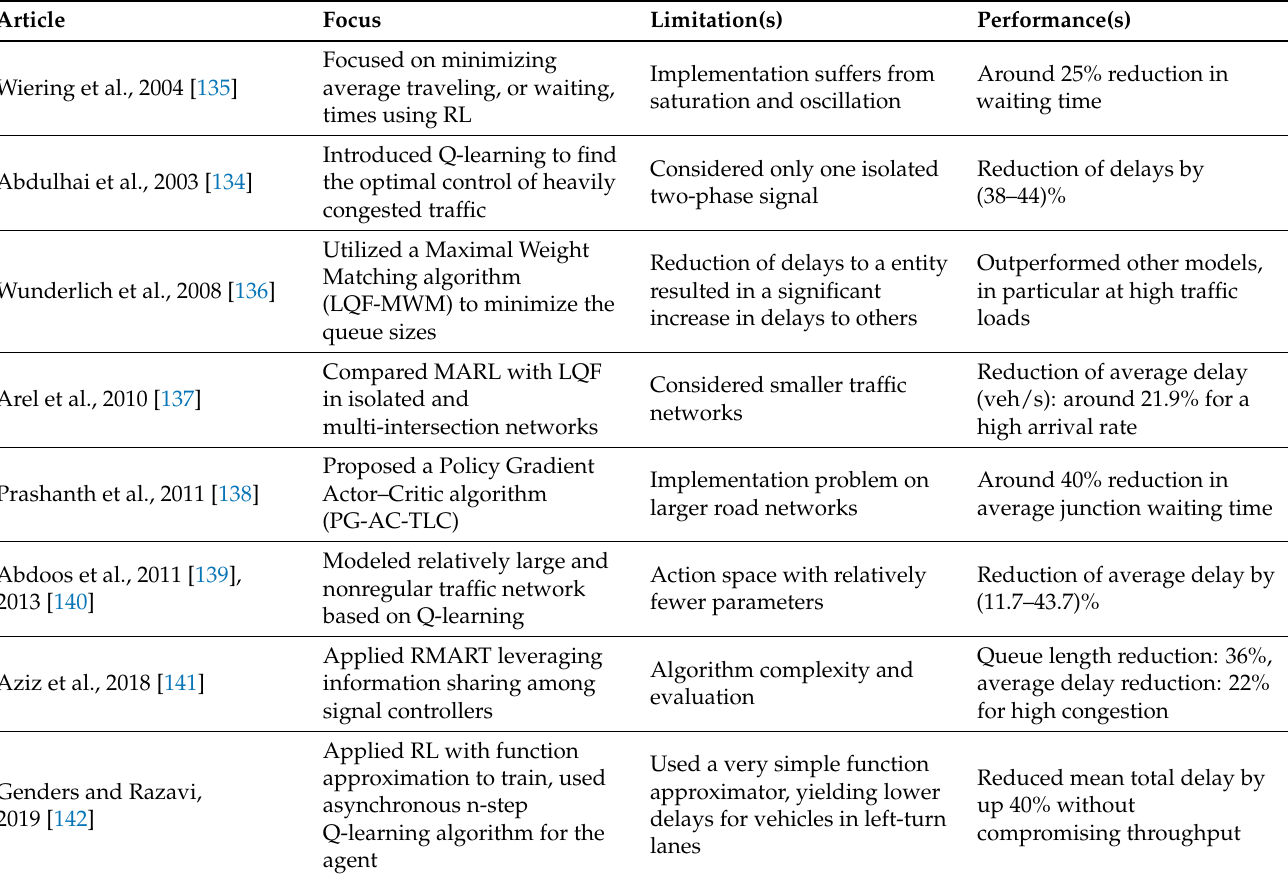
Table 23. Summary of the works found related to the Q-learning